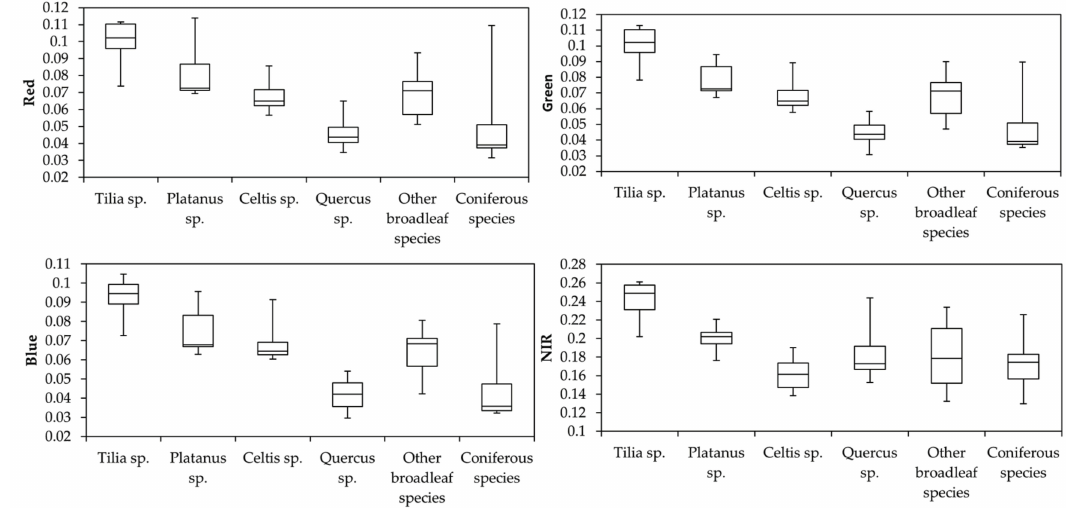
Figure 2. Mean spectral values within each of the spring Pl é iades image spectral bands of the six classes over the study area.